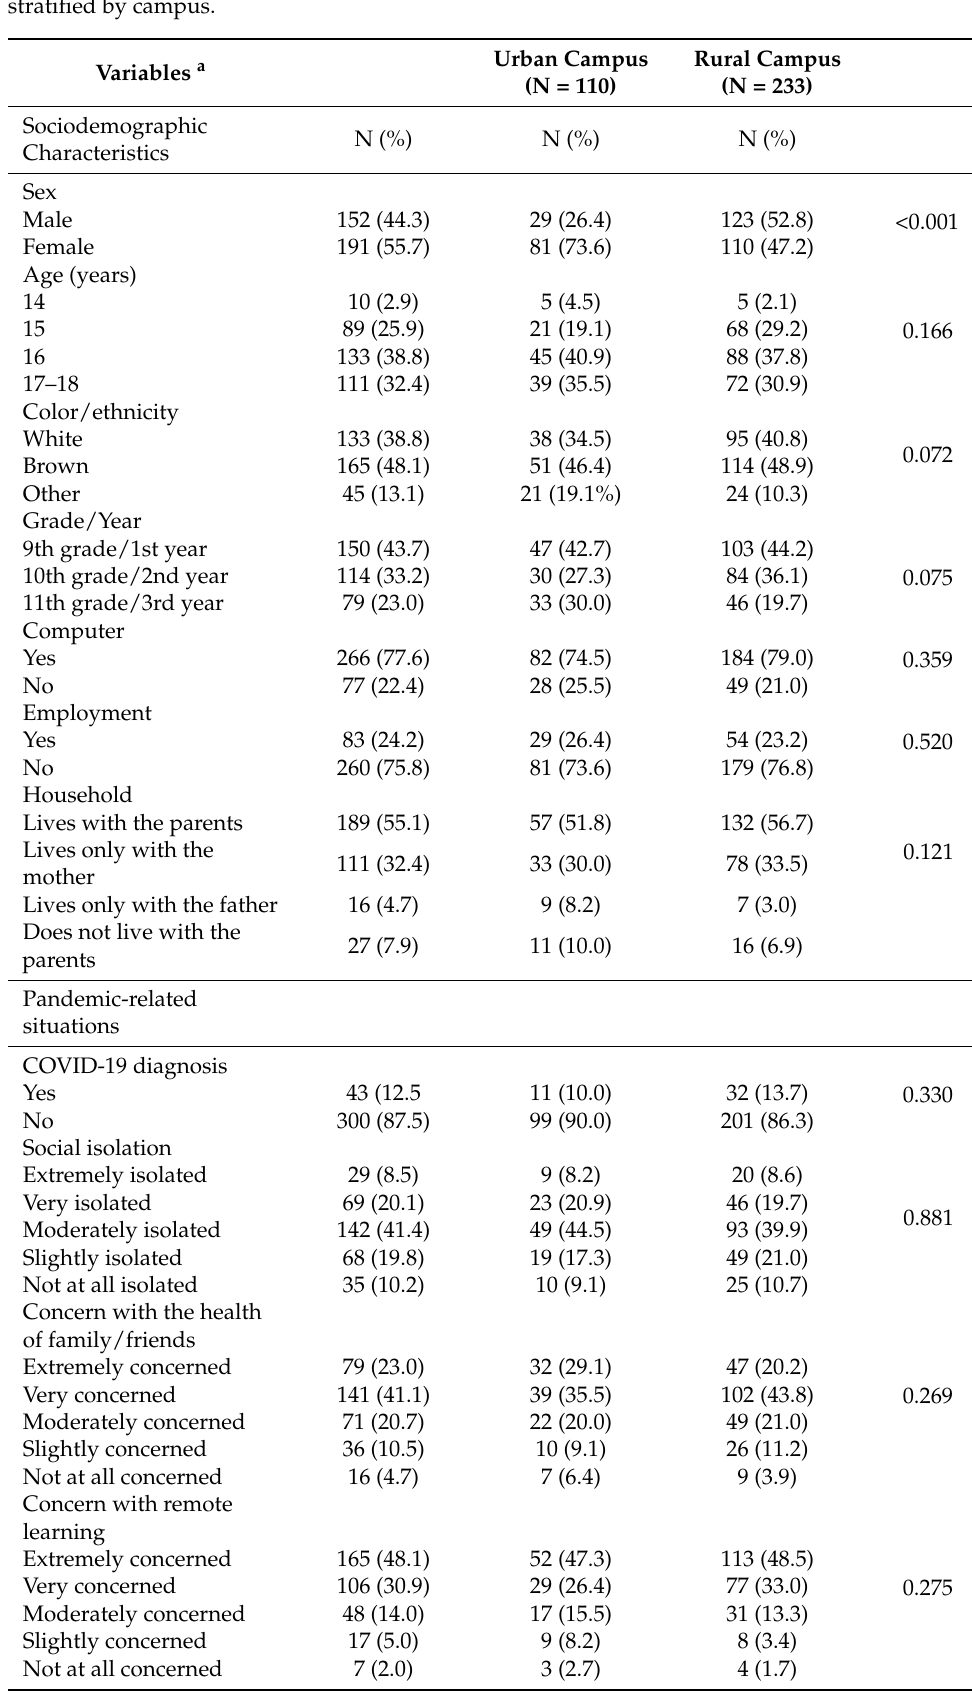
Table 1. Sociodemographic characteristics and COVID-19-pandemic-related situations in the sample, stratified by